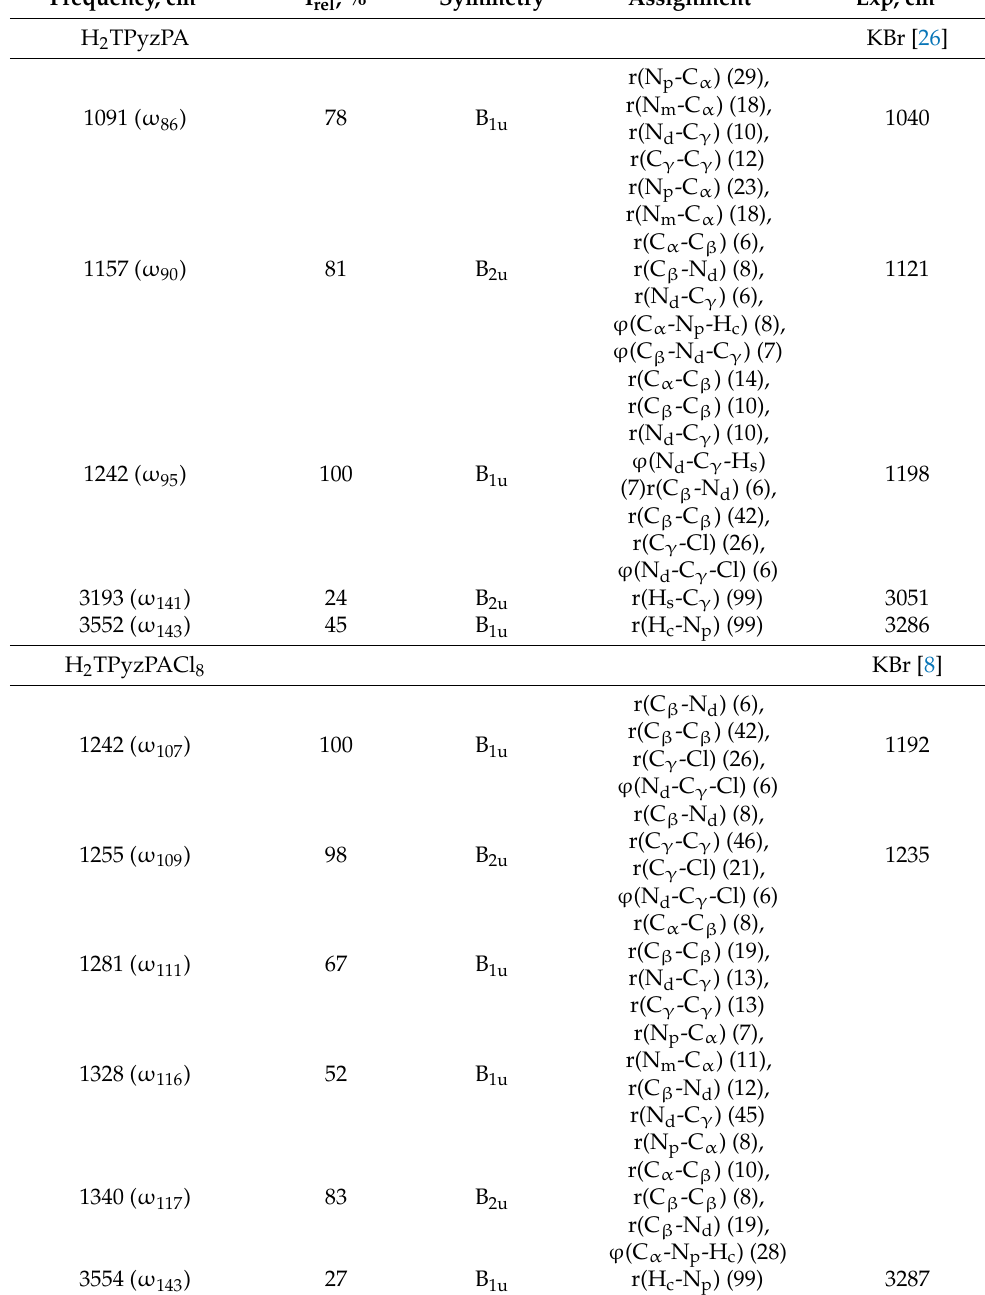
Table 4. Assignment of the IR vibrations of the M(Cl)TPyzPA and M(Cl)TPyzPACl 8